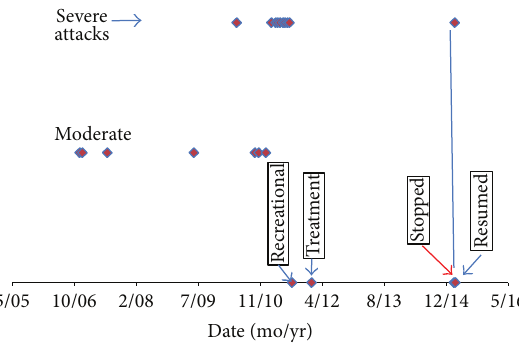
Figure 1: Attack severity by